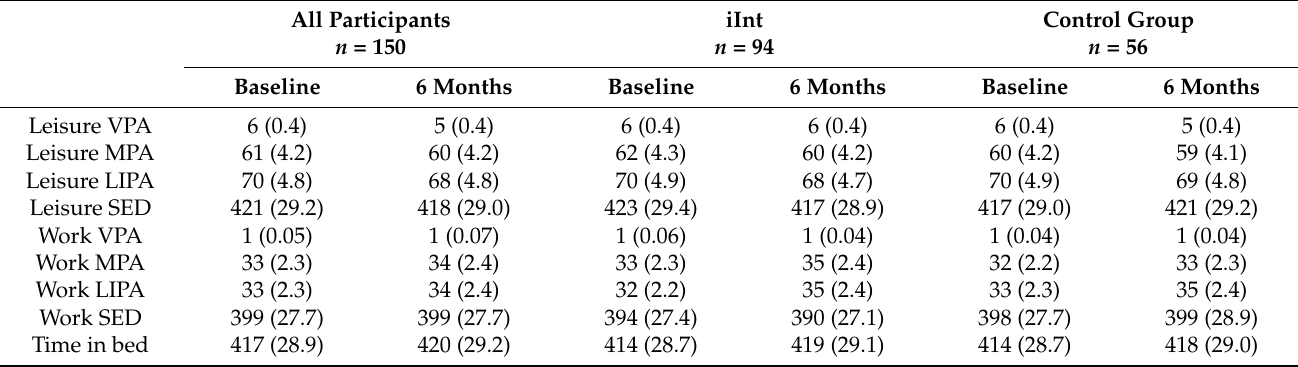
Table 5. Baseline and 6-month follow-up values for minutes spent in domain-specific 24-h movement behaviors (composi- tional mean and % of 24-h in parentheses).